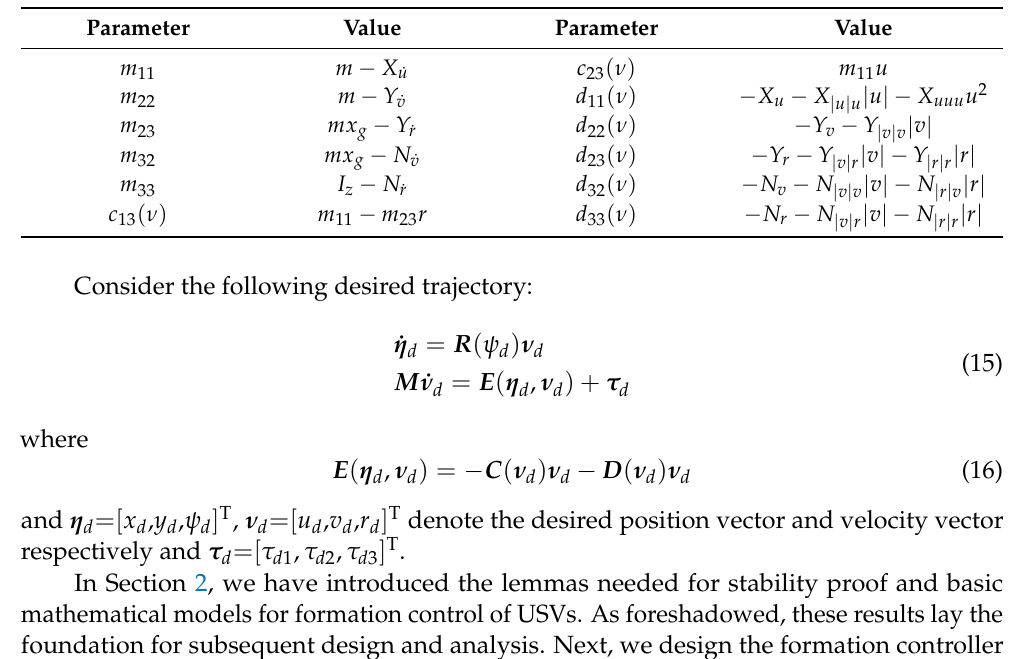
Table 1. Definitions of parameters in M , C , and D